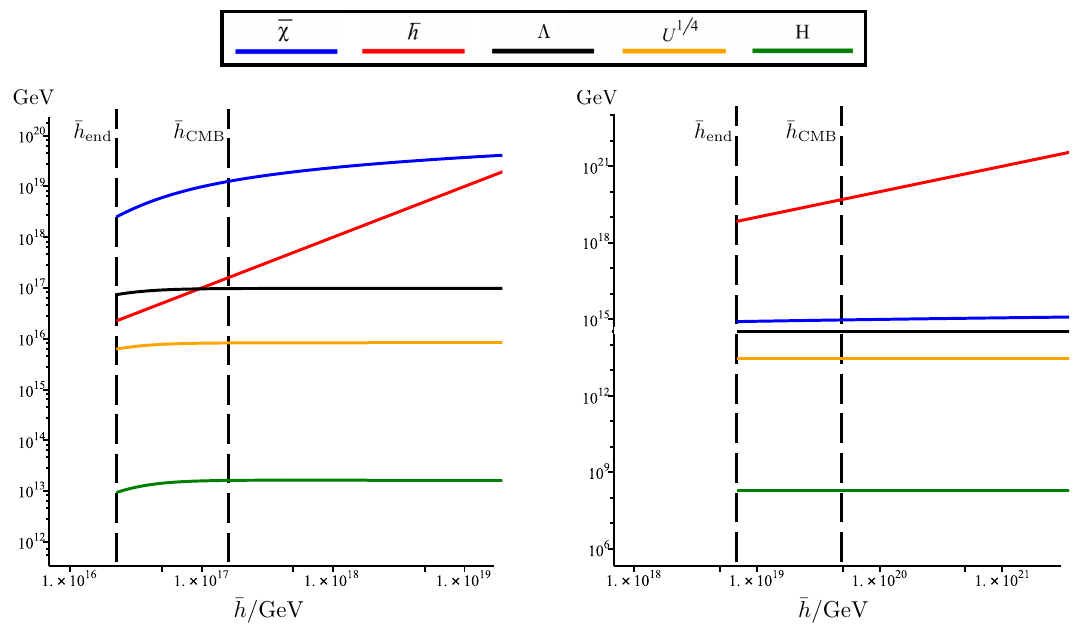
Figure 1 . Different scales as a function of the background field ¯ h in the metric formulation (left) and the Palatini formulation (right). The blue line is the canonical background field ¯ χ , the red line is the background field ¯ h , the yellow line is the energy density scale U 1 / 4 , the black line is the unitarity violation scale Λ , and the green line is the Hubble rate H . The dashed vertical lines labelled h end and h CMB mark the end of inflation and the CMB pivot scale,